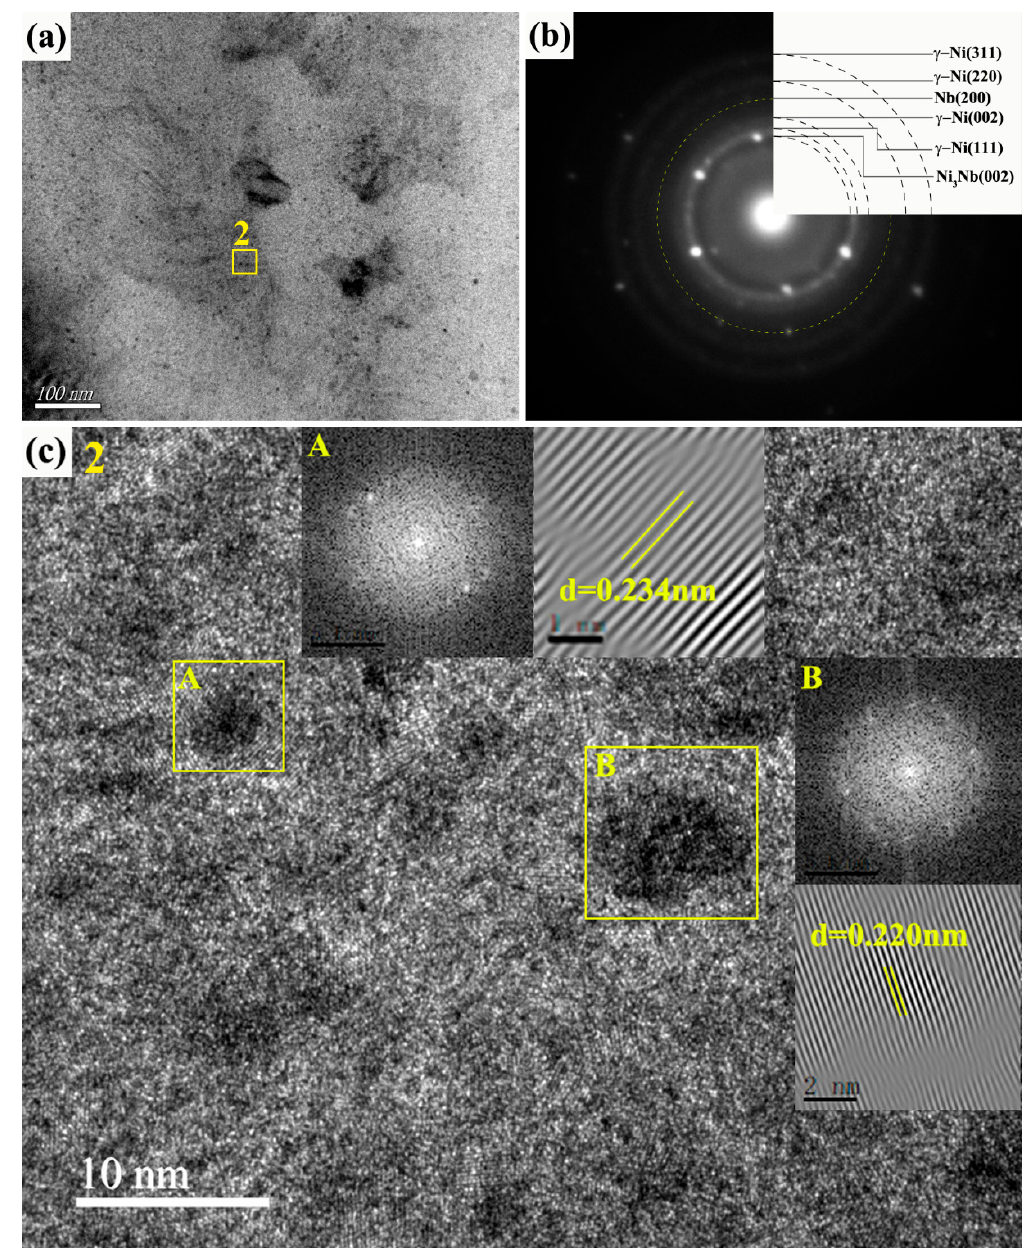
Figure 7. The TEM image, SEAD pattern, and HRTEM image of 30-pulsed Ni-Nb layer. ( a ) The TEM bright field image of Ni-Nb layer; ( b ) The SEAD pattern of ( a ); ( c ) The HRTEM image of region 2 in ( a ).